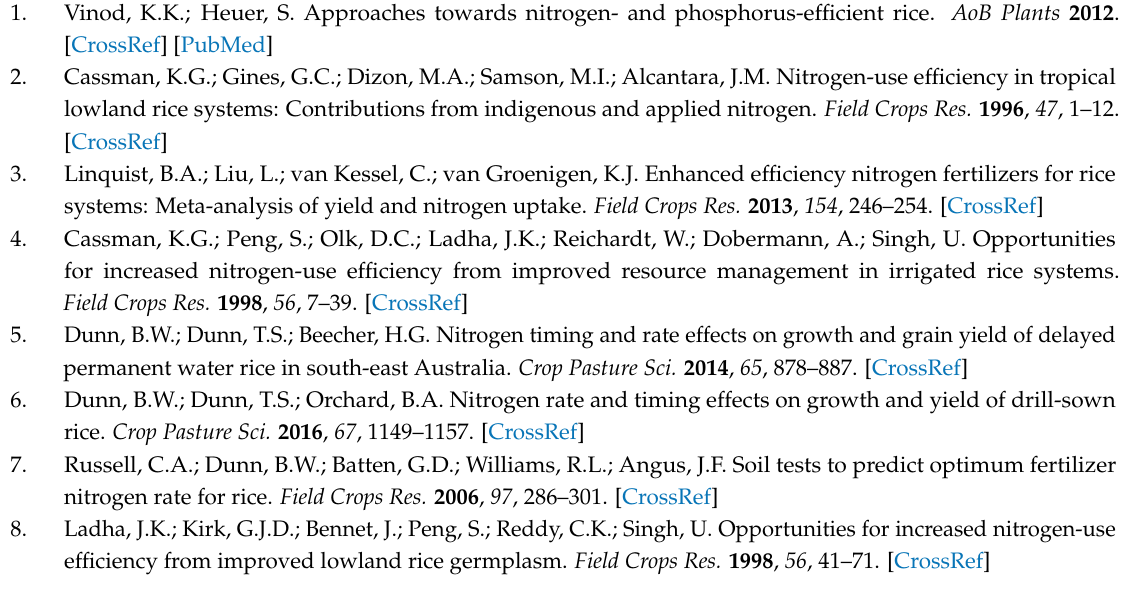
Table S1: Nitrogen concentrations in rice (cv. IR64) grain and aboveground biomass during grain filling under high yielding field